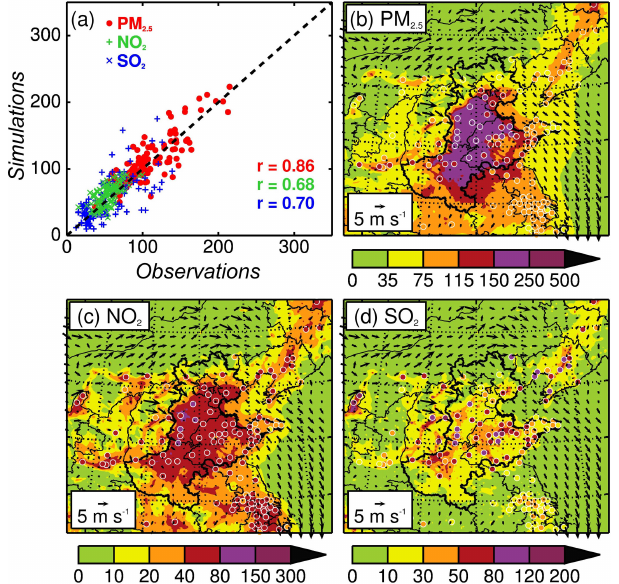
Figure 7. The potential emission reductions for low- (left panels) and high-limit (right panels) cases induced by the GLP, including the mass rates change in (a) NO x and (b) SO 2 . The total emission reductions are also shown in the